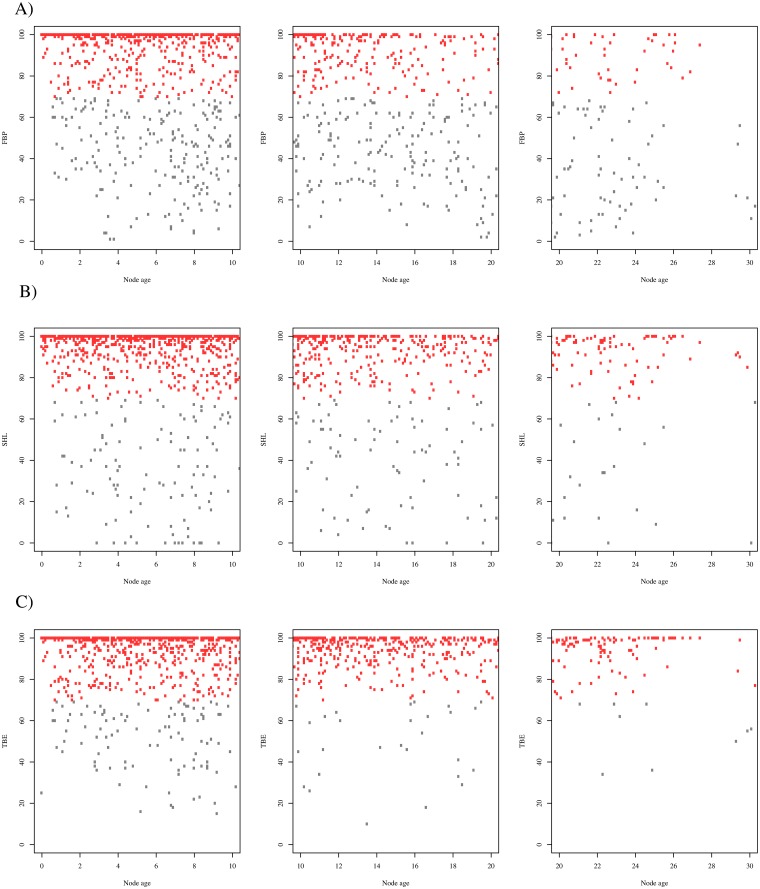
Distribution of branch support scores for each node age based on the
Maximum likelihood species-level phylogeny of Colubroides.A) FBP distribution, B) SHL distribution, C) TBE distribution. Red dots
represent values greater than 70%; gray dots indicate values smaller than
70%.